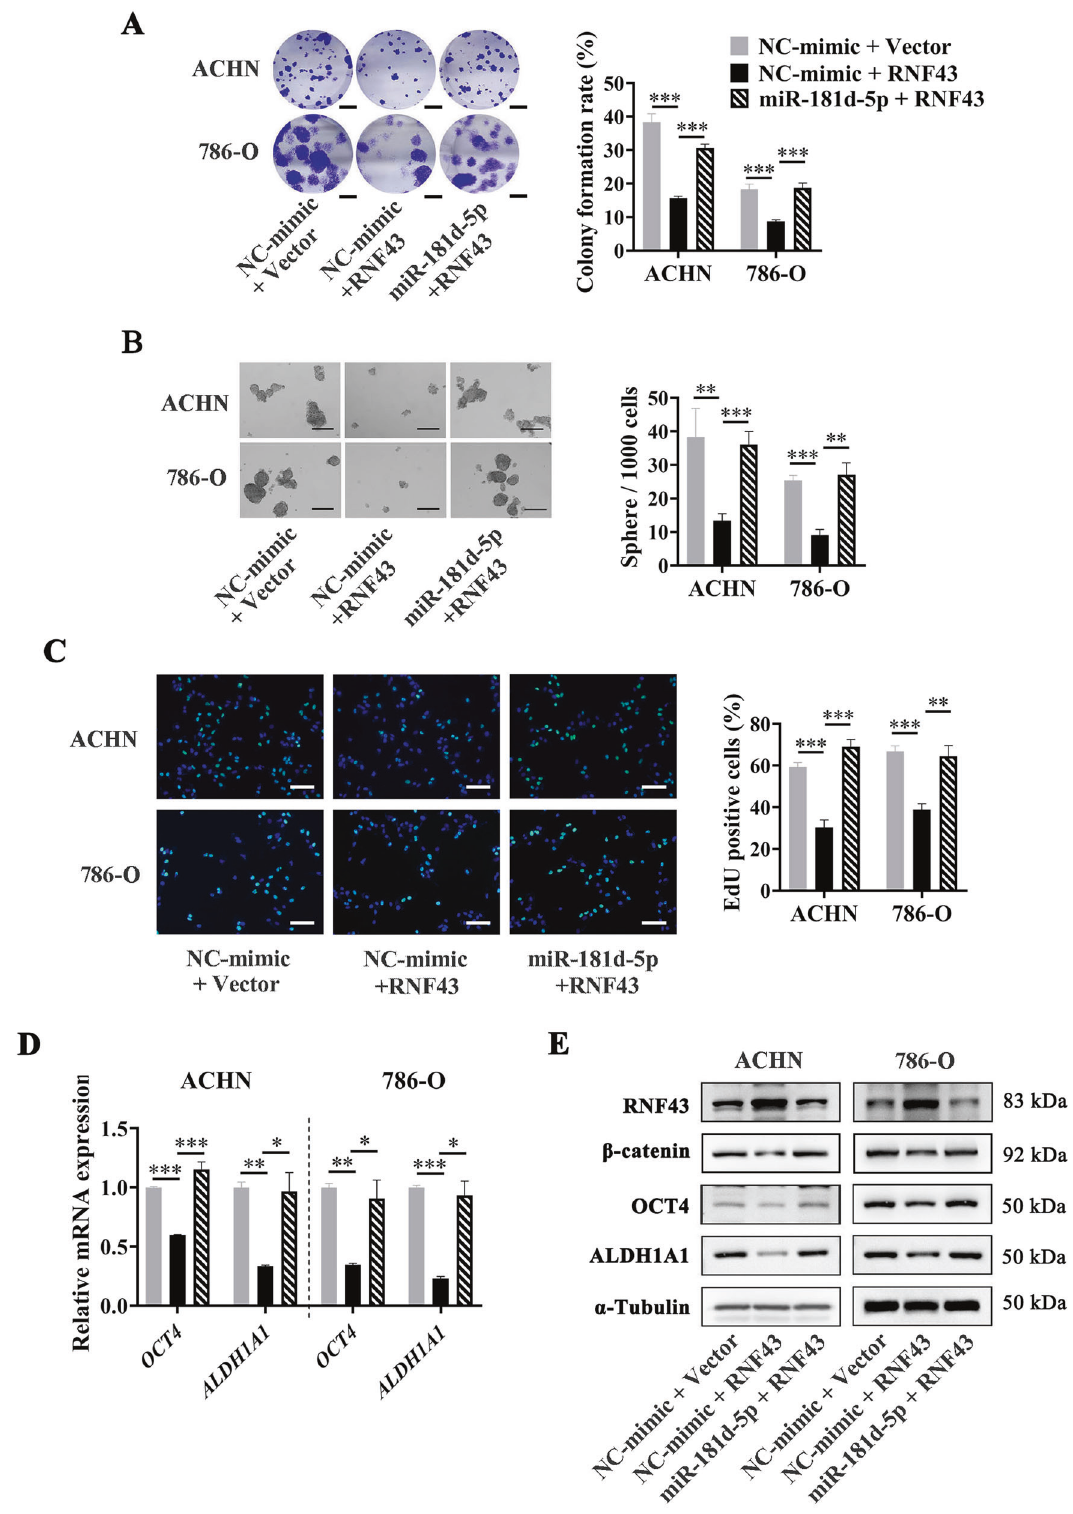
Fig. 8 miR-181d-5p promotes cancer stemness and RCC progression by suppressing RNF43 and activating Wnt/ β -catenin signal in vitro. A Representative images (Left) and histogram statistics (Right) of colony formation in RCC cells transfected with RNF43, or RNF43 plus miR- 181d-5p mimics, scale bar = 0.5 cm. B Representative images (Left) and histogram statistics (Right) of sphere formation in RCC cells transfected with RNF43, or RNF43 plus miR-181d-5p mimics, scale bar = 100 µm. C Representative images (Left) and histogram statistics (Right) of EdU assay in RCC cells transfected with RNF43, or RNF43 plus miR-181d-5p mimics, scale bar = 50 µm. D RT-qPCR analysis of mRNA levels in RCC cells transfected with RNF43, or RNF43 plus miR-181d-5p mimics, normalized to β -actin ; E Western Blot analysis of protein levels in RCC cells transfected with RNF43, or RNF43 plus miR-181d-5p mimics, normalized to α -Tubulin. Cell experiment was repeated three times independently, P value between two groups was obtained by Unpaired t test. * P < 0.05; ** P < 0.01; *** P < 0.001. Cell Death Discovery (2022)